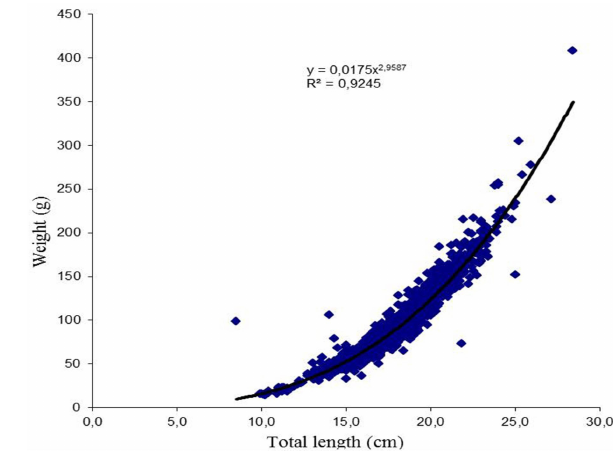
Fig. 1. Study area (Lake Beysehir) and sampling stations: 1.